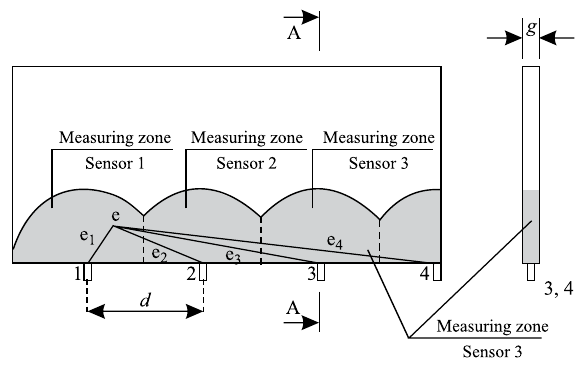
Fig. 3. Overlapping measuring surfaces – measuring zones